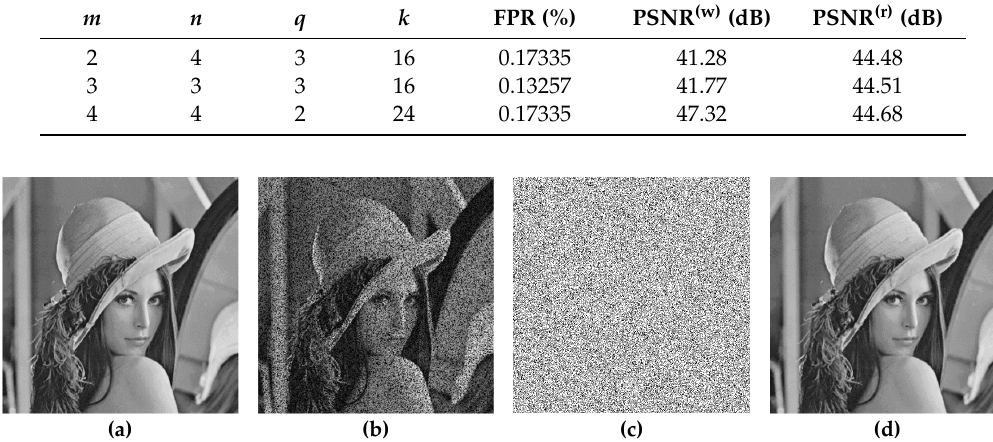
Figure 7. Watermarked Lena and tamper detection results using 4 × 4 pixel-wise detection ( a ) Watermarked image ( PSNR (w) = 41 dB ), ( b ) tampered image (Tamper rate = 30 %), ( c ) tamper detection result ( FPR = 0% ), ( d ) recovery image ( PSNR ( r ) = 40.68 dB ).